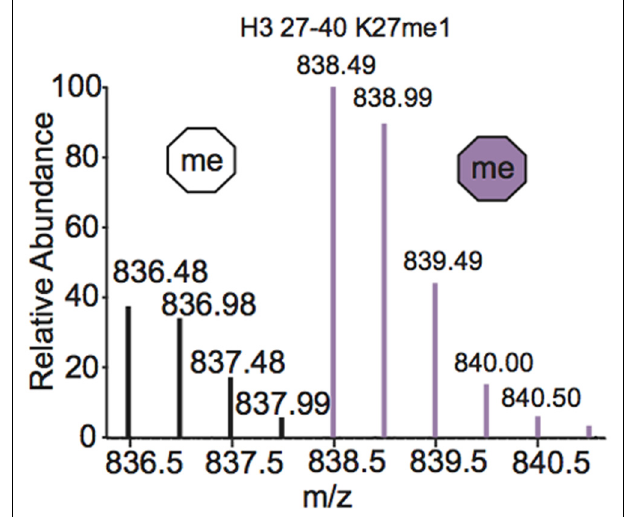
FIGURE 4 | Mass spectrum displaying the (M + 2H) 2+ H3 27–40 peptide containing K27me1 from cells 12 h after addition of ( 13 CD 3 )- S - adenosyl methionine. Both unlabeled peptide (white hexagon) and heavy-methyl labeled peptide (purple hexagon) are observed. Spectra is from data obtained in Zee etal.